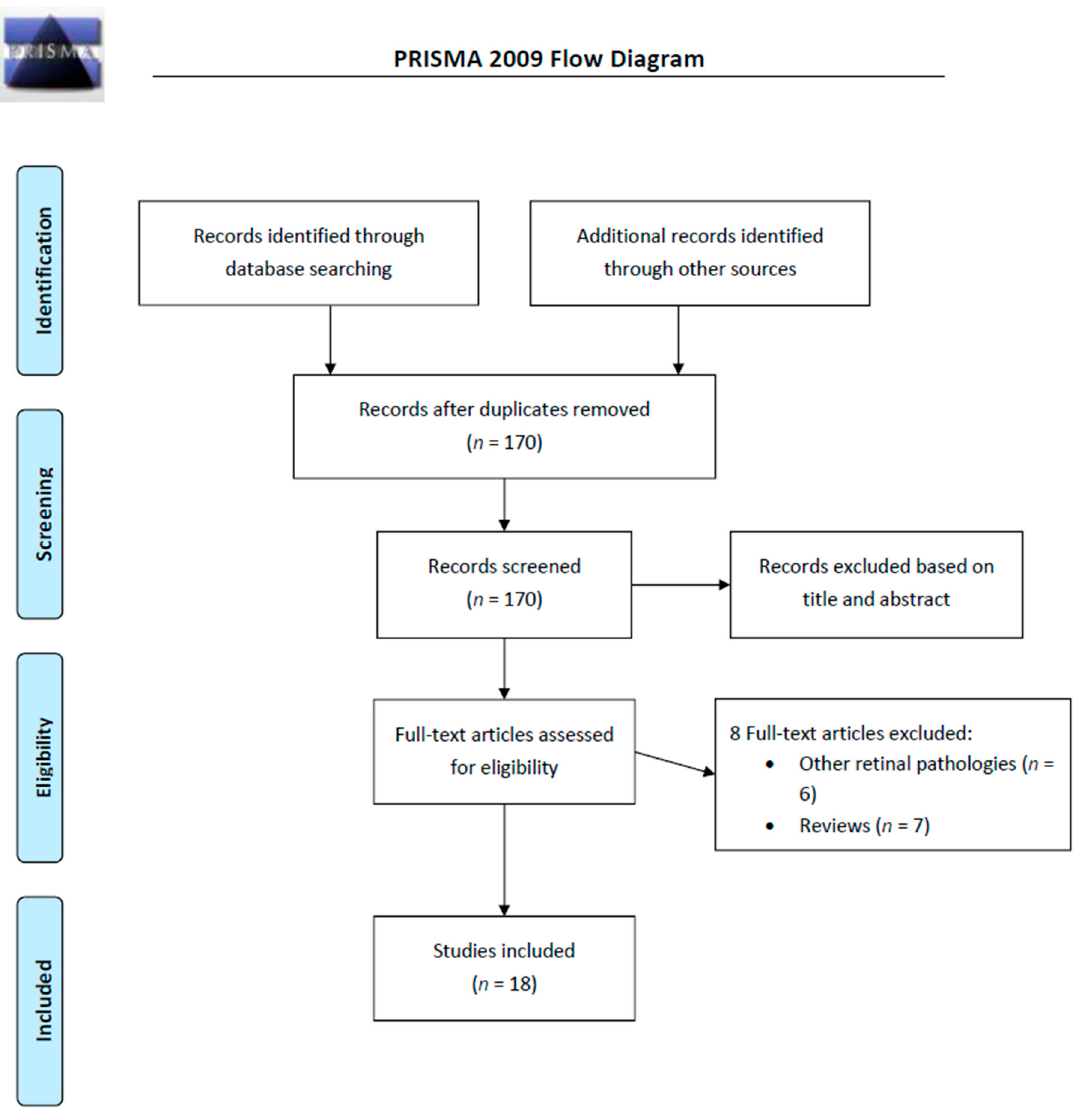
Figure 1. PRISMA 2009 flow diagram of the included studies.